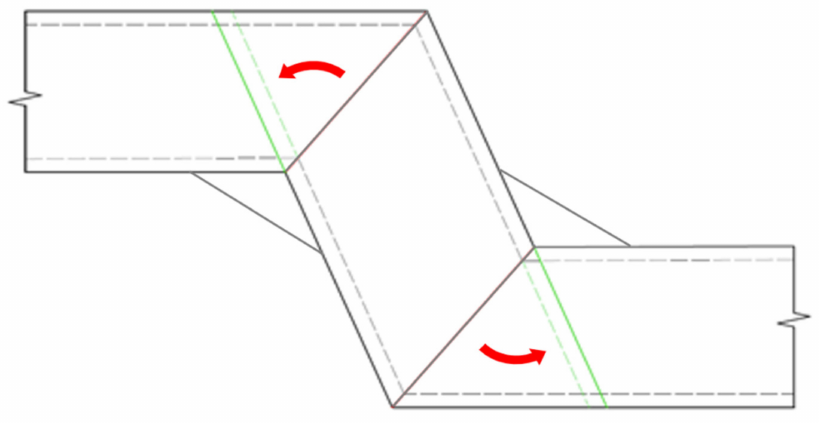
Figure 11. Implementation of crossbar reinforcement, –– the original state, –– a new state.